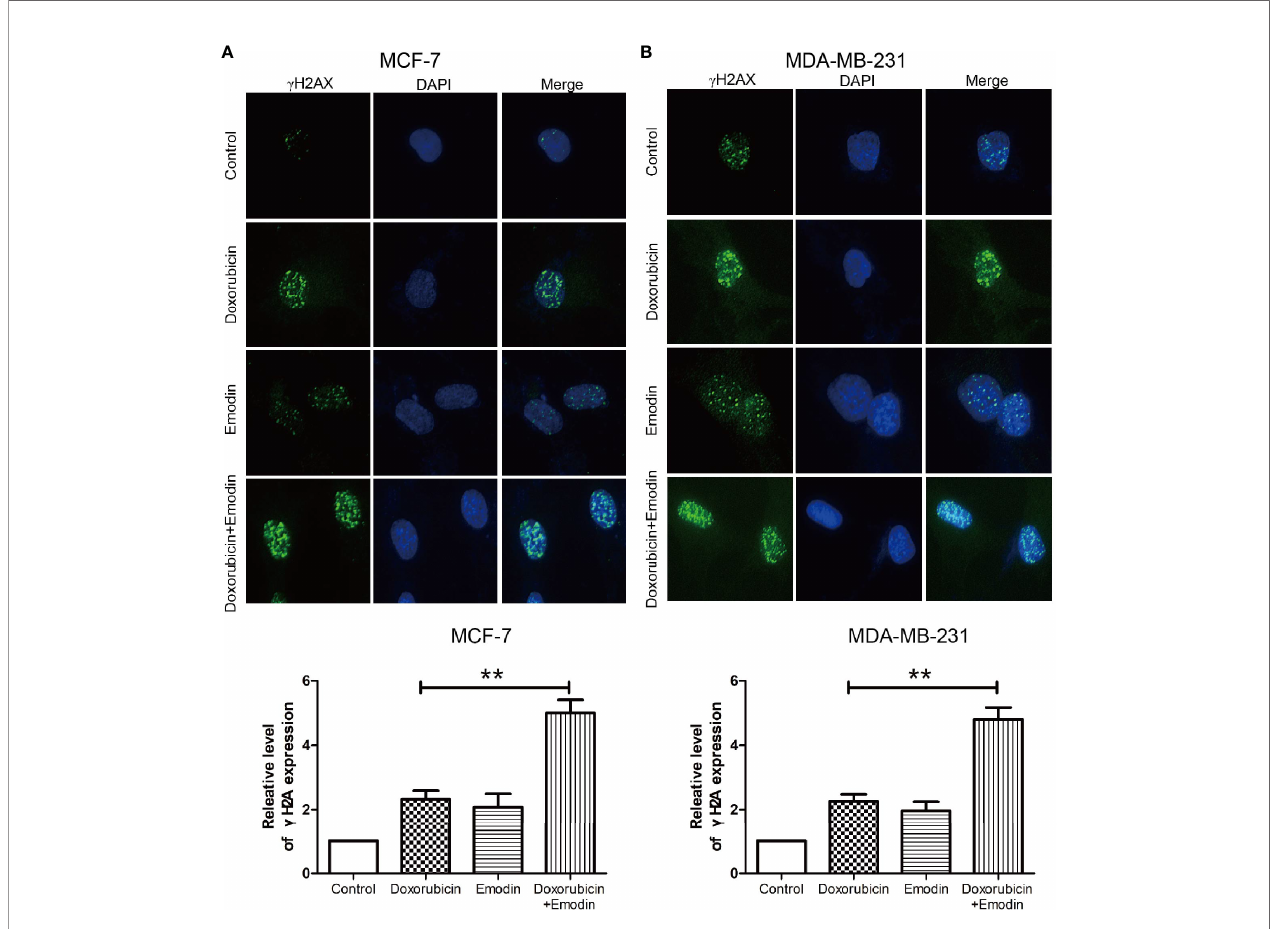
FIGURE 4 | Emodin promotes DSB induced by doxorubicin. g H2A staining shows Emodin (110 m M) increases the expression of g h2A and promotes tailing in (A) MCF-7 and (B) MDA-MB-231 cells as induced by doxorubicin (5 m M). ** P < 0.01 vs doxorubicin group. The analysis was conducted using the Student ’ s